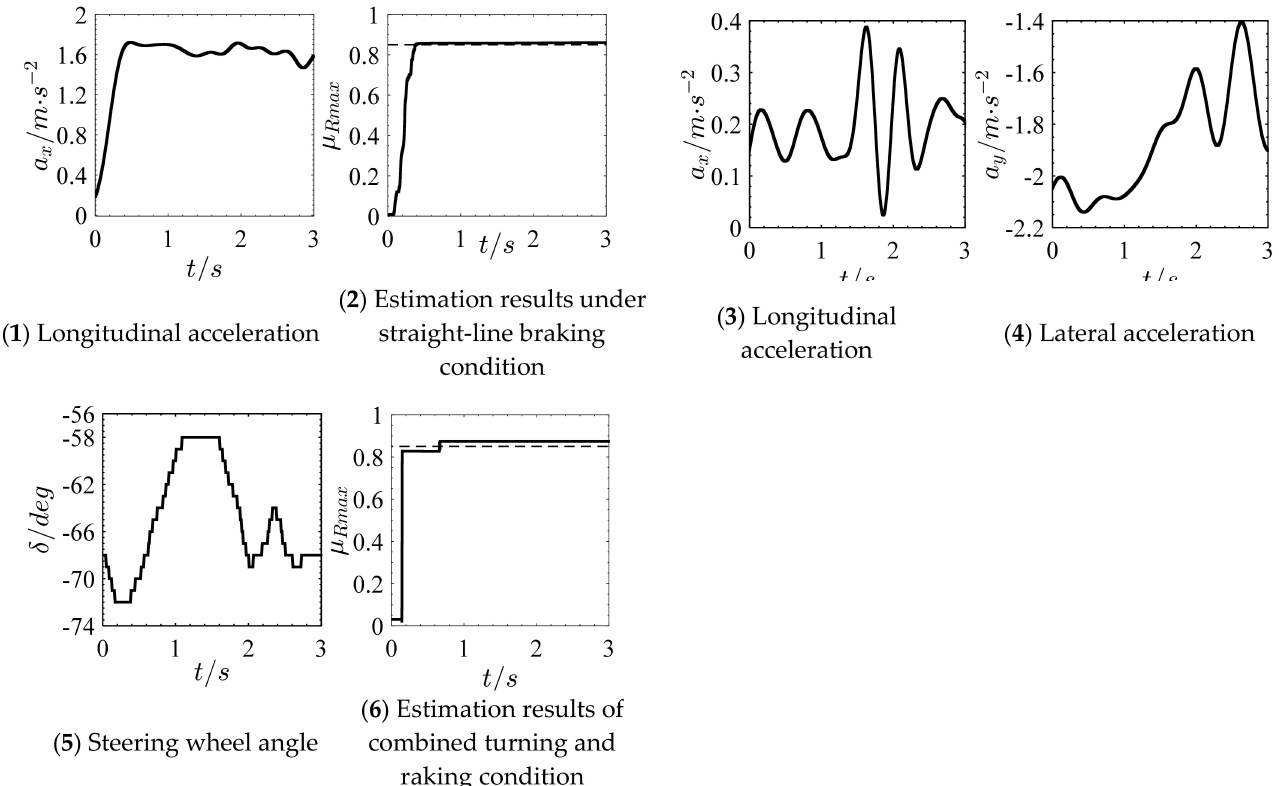
Figure 9. Real vehicle test